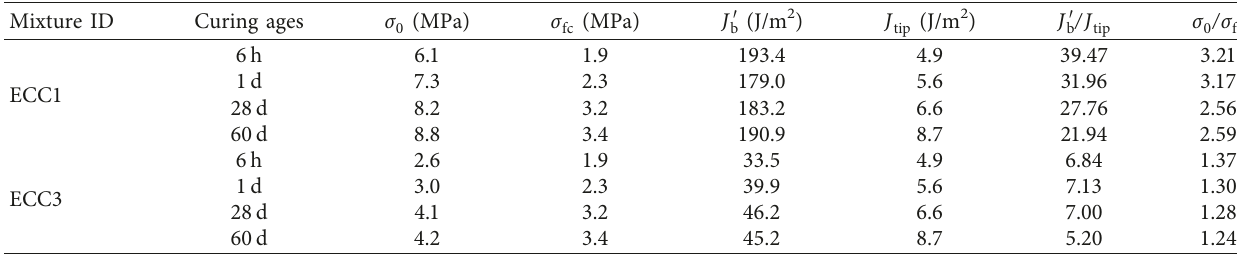
Table 4: Strain-hardening performance index of HES-ECCs with different